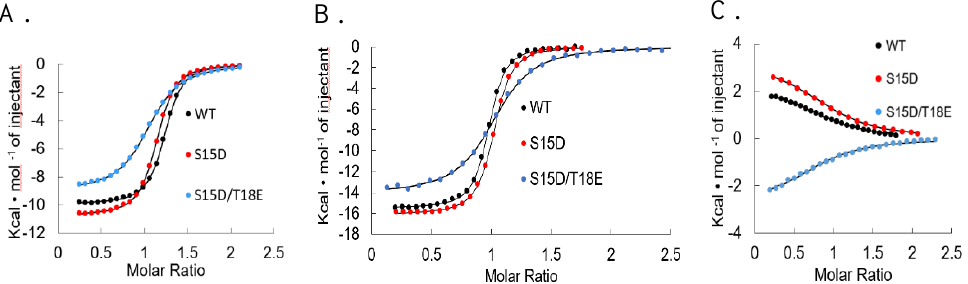
Figure 3. Binding Isotherms of Mdm2, MdmX and KIX with p53TAD and mutants. Isothermal calorimetry titrations of ( A ). Mdm2 and p53TAD and mutants ( B ). MdmX and p53TAD and mutants and ( C ). KIX and p53TAD and mutants. WT: wild type Table 1. Isothermal titration calorimetry (ITC) values for interactions between Mdm2, MdmX and KIX with p53TAD and mutants.